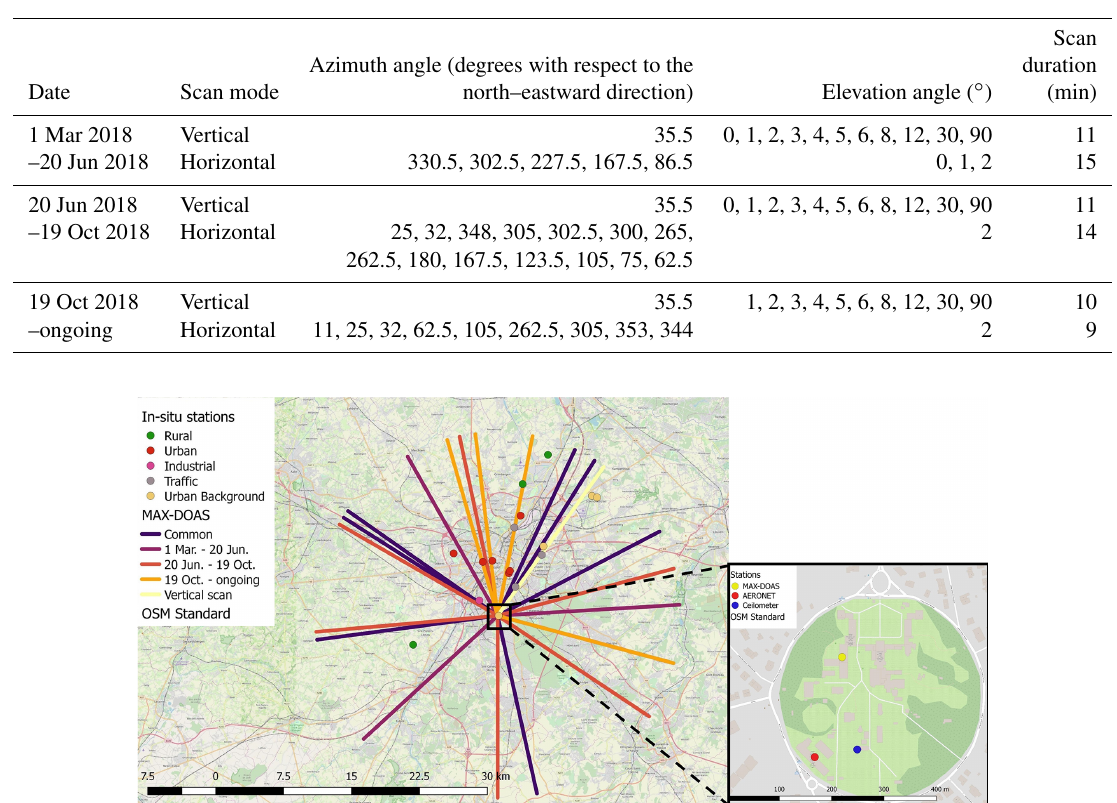
Figure 1. The dual-scan experimental setup of the BIRA-IASB MAX-DOAS instrument (overlaid onto the OpenStreetMap (OSM) standard layer) (left panel). The lines are color-coded according to the three different experimental setups (Table 1), with a line length of 20km each. The colored dots show the different types of in situ stations around the MAX-DOAS instrument (see Sect. 4.2). The right panel shows the location of the MAX-DOAS, AERONET and ceilometer instruments at the measurement site. ©OpenStreetMap contributors 2019. Distributed under a Creative Commons BY-SA